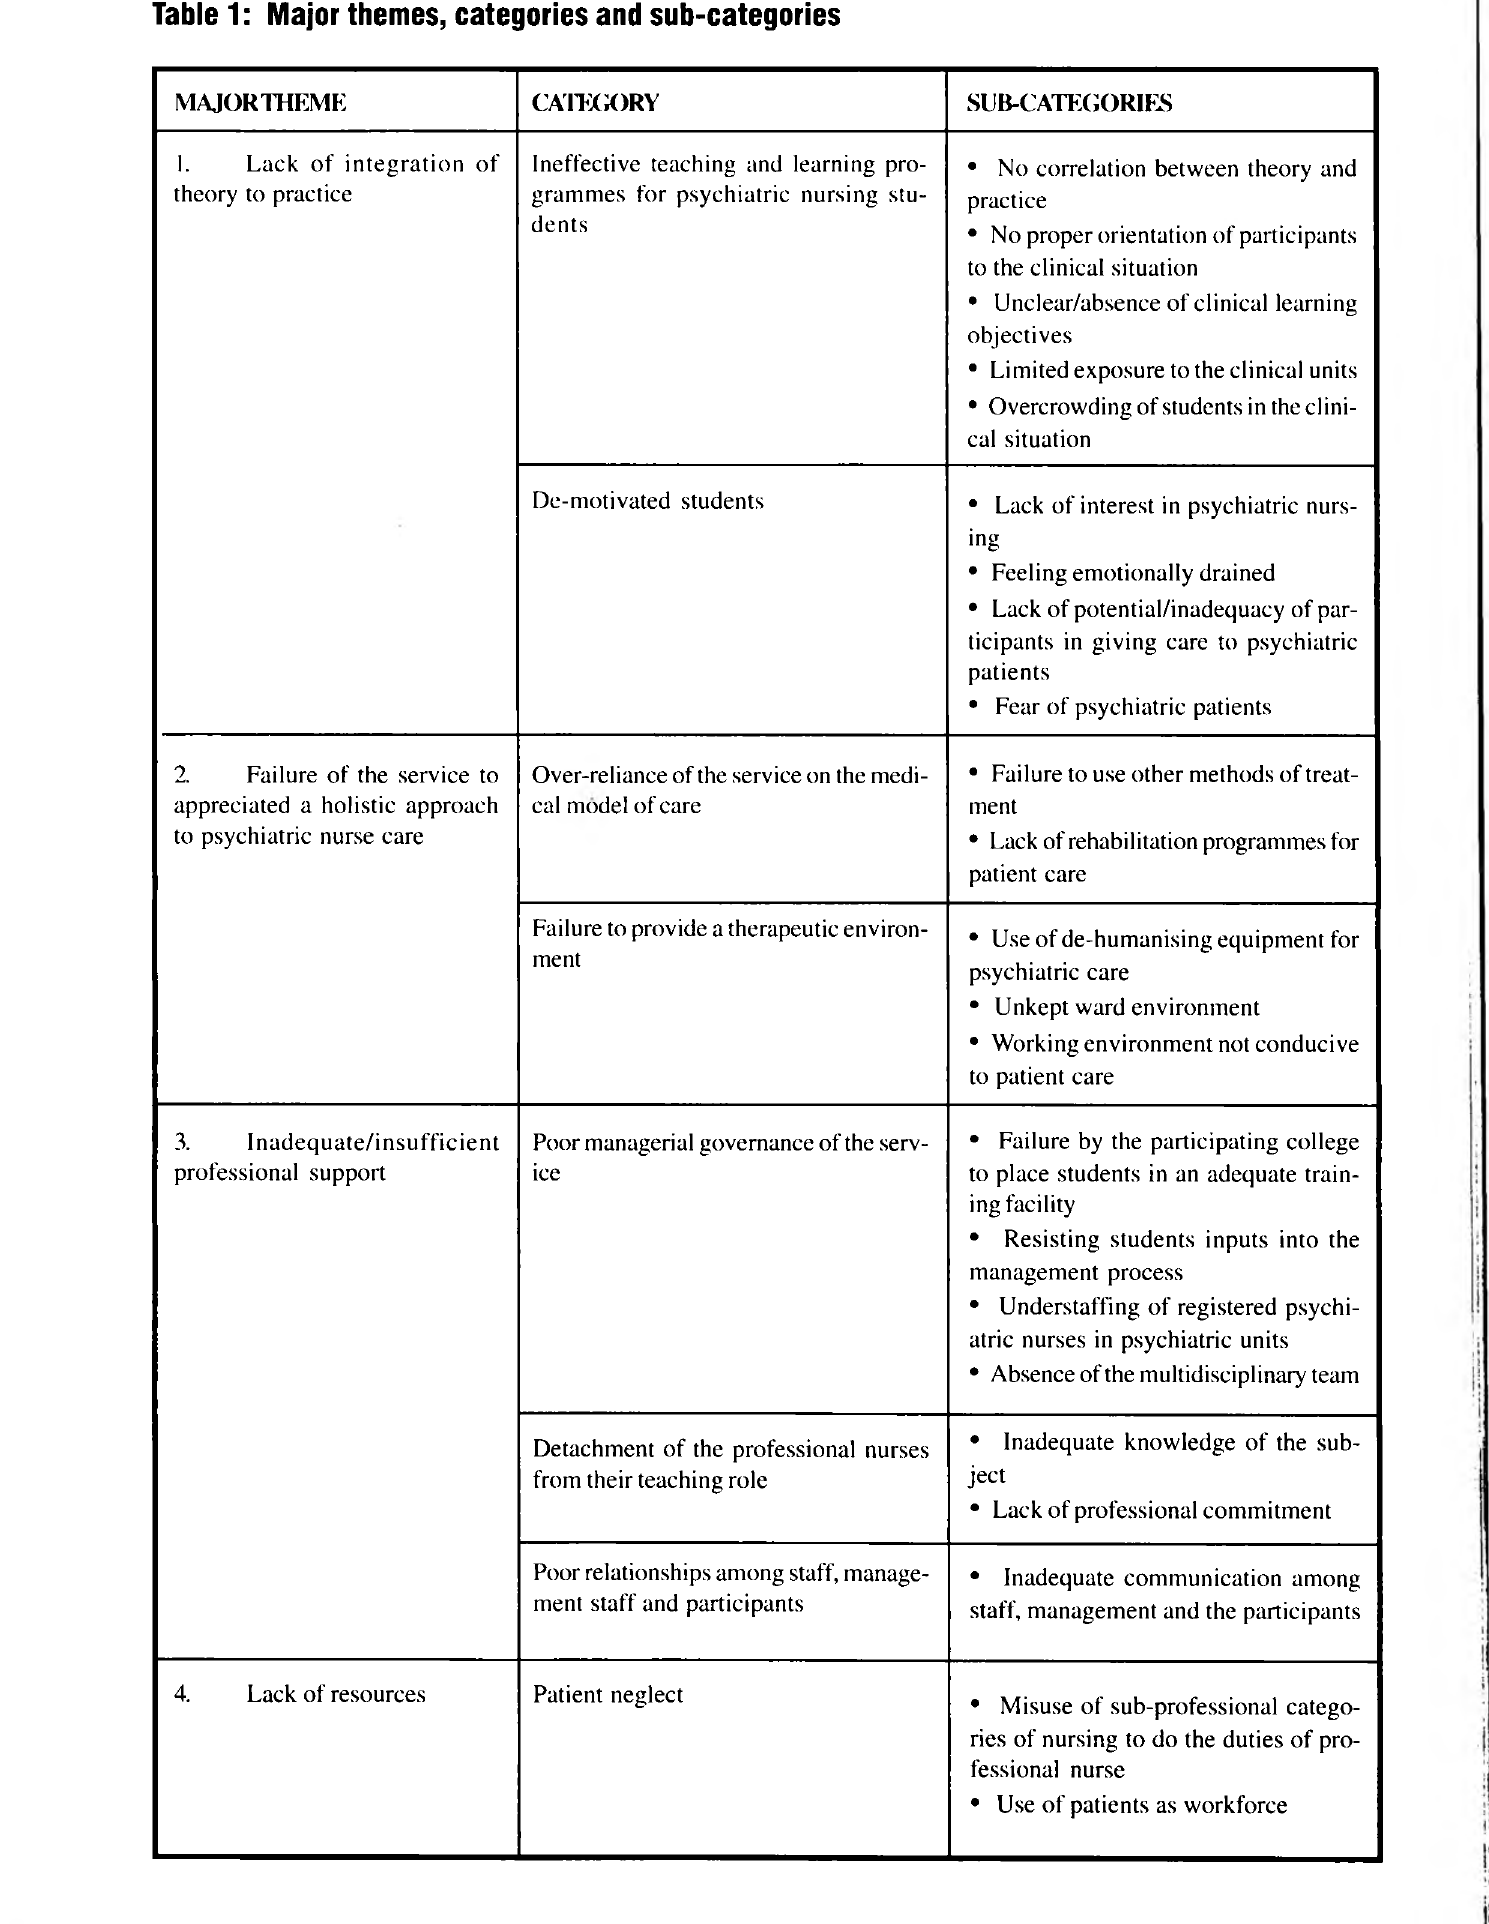
Table 1 : Major themes, categories and